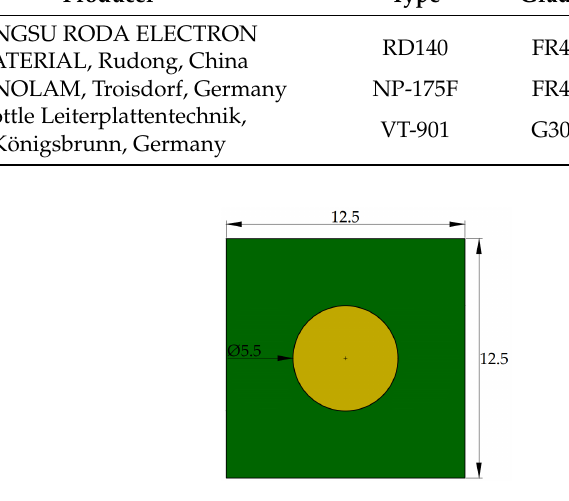
Figure 2. Design of the testing board.